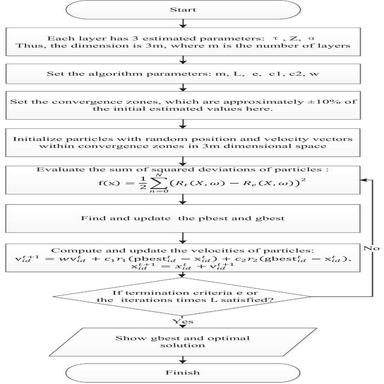
Flow chart of the proposed PSO-based least squares algorithm for estimating the properties of multi-layered materials using the reflection spectrum.